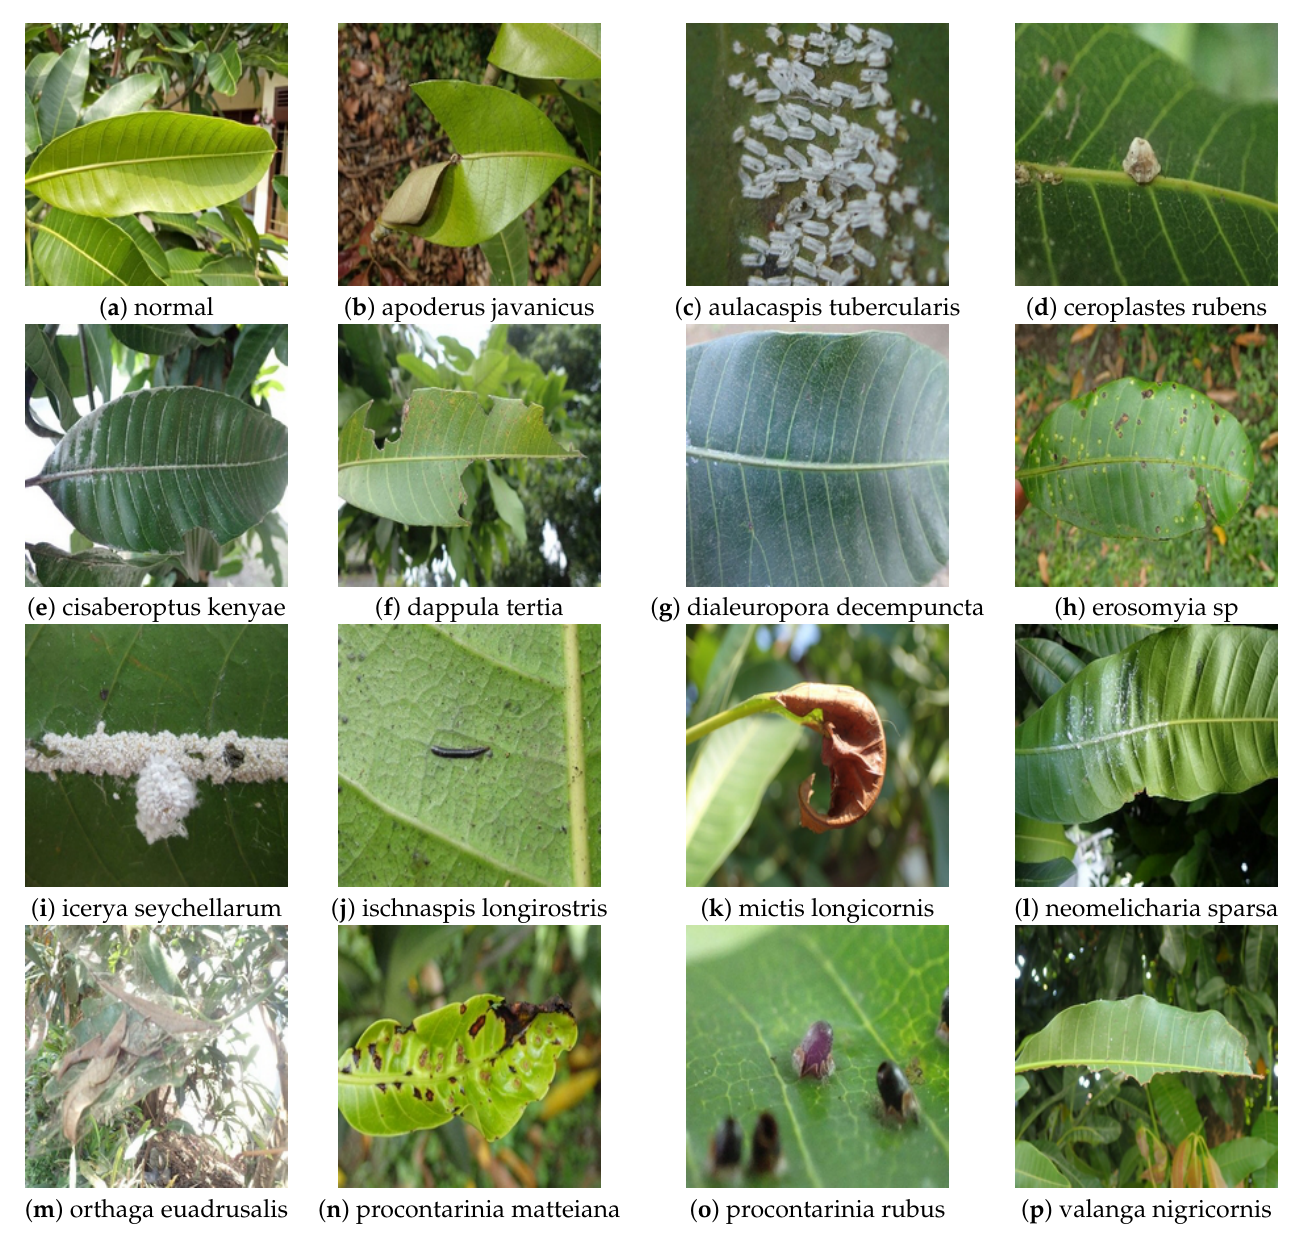
Figure 7. Sample images of pest classification in mango